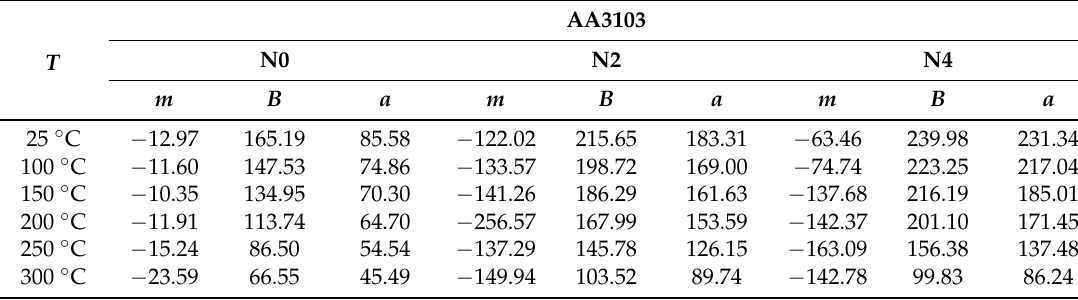
Table 8. Values for Voce’s parameters in the case of AA3103.